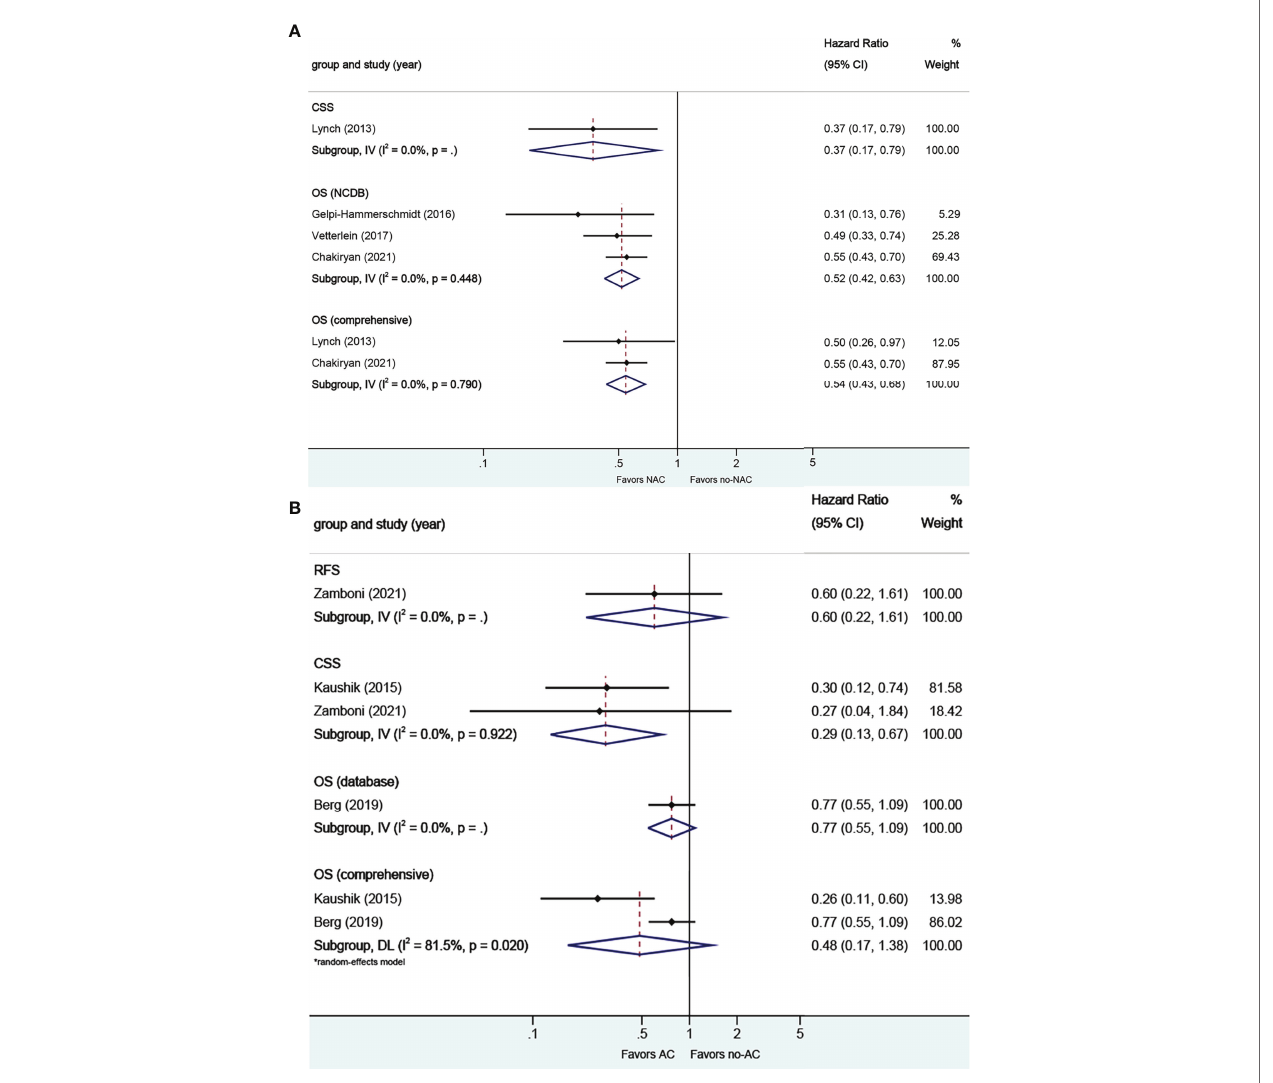
FIGURE 8 | Forest plots of studies investigating the association of chemotherapy with survival outcomes in neuroendocrine variant histology. (A) neoadjuvant chemotherapy; (B) adjuvant